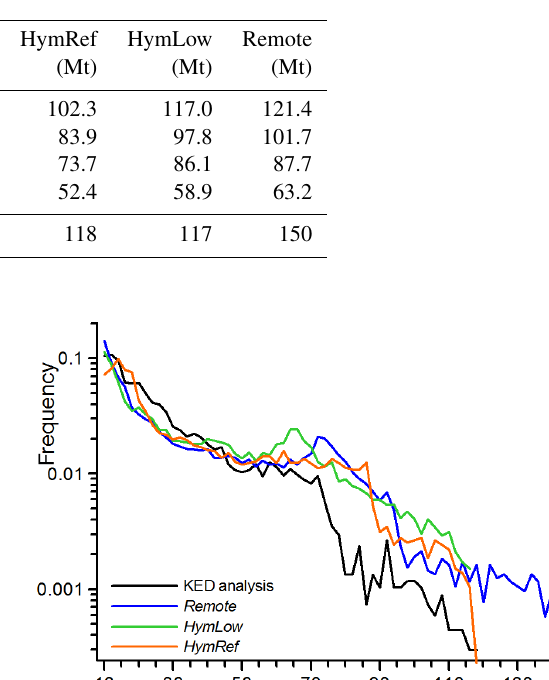
Table 2. Total mass of rainwater (in megatonnes) recorded and simulated for the period from 06:00 to 11:00UTC, 26 September 2012 for different thresholds of rain accumulation. The bottom line gives the local maximum values occurring for observed and simulated rain accumulation (in millimetres).